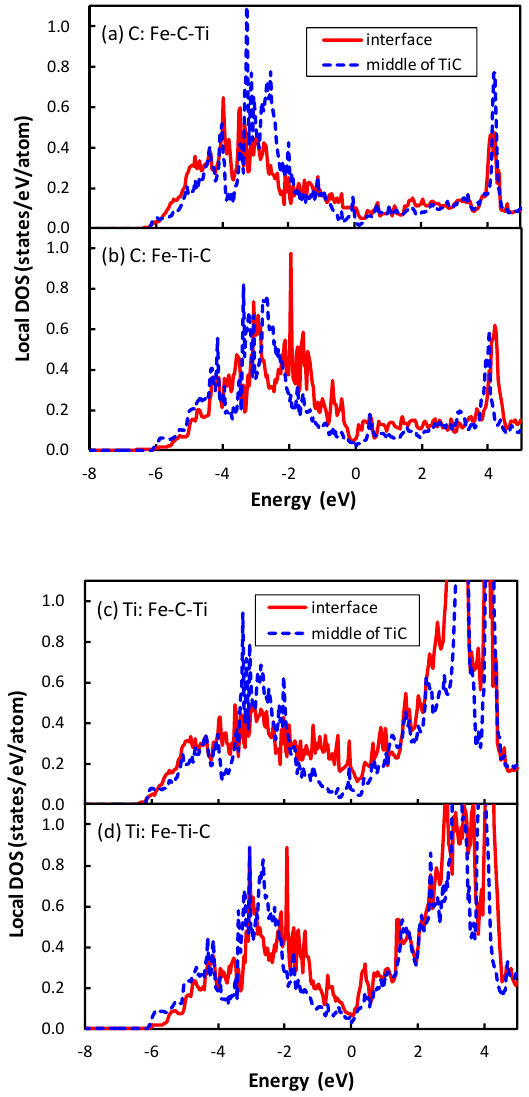
Figure 3. Local density of states (DOS) of the C atoms ( a , b ) and Ti atoms ( c , d ) located at the interface and the middle of TiC. For the atomic arrangement at the interface, ( a , c ) correspond to the case that the C atom is directly connected with the Fe atom across the interface; and ( b , d ) correspond to the case that the Ti atom is connected with the Fe atom. The solid red lines and blue dashed lines denote the local DOS at the interface and the middle of TiC, respectively. The Fermi level is set as